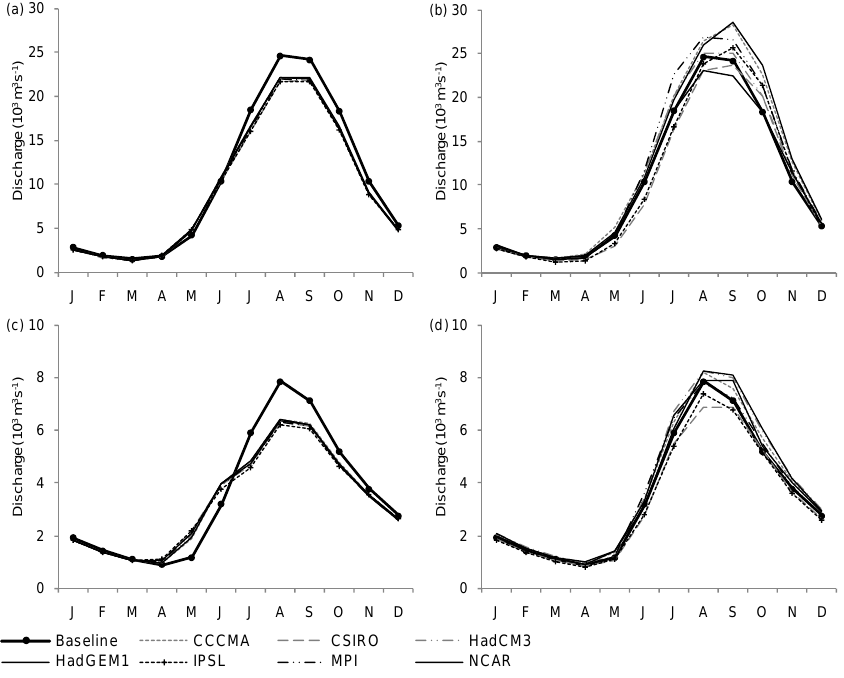
Fig. 6. 2 ◦ C climate change signal across seven GCMs for the Mekong at Pakse (Mekong 2): (a) temperature only, (b) precipitation only; and Lancang at Chiang-Saen: (c) temperature only, (d) precipitation only.